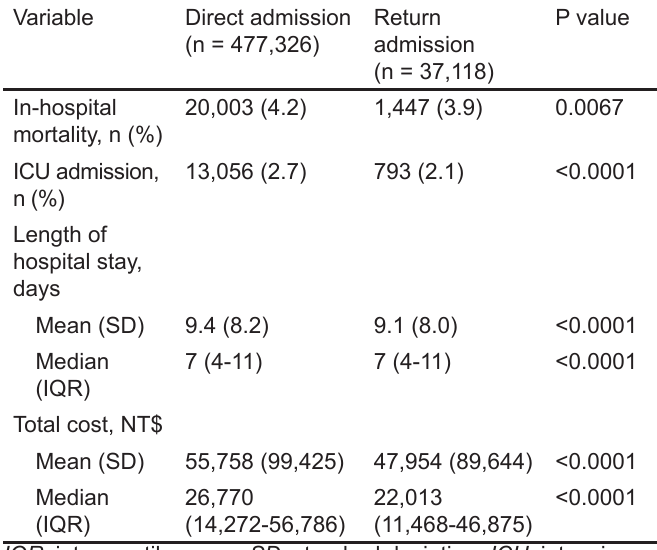
Table 3. Study outcomes by revisit status (unadjusted).